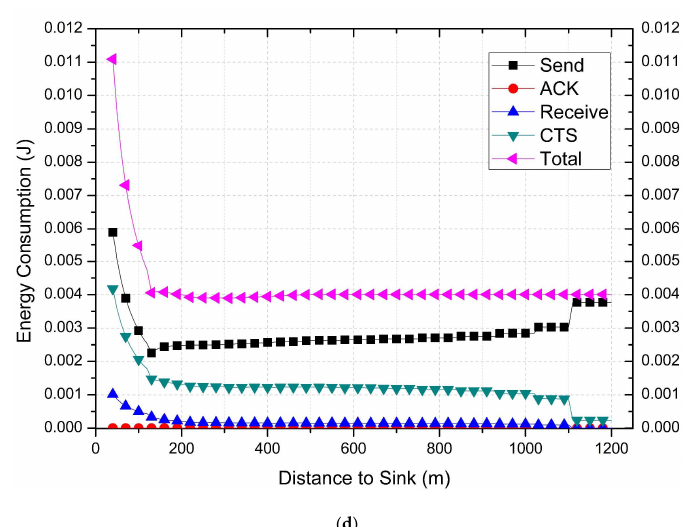
Figure 21. ( a ) Energy consumption of node under r =60, N = 2; ( b ) Energy consumption of node under r = 70, N = 3; ( c ) Energy consumption of node under r = 80, N = 4; ( d ) Energy consumption of node under r = 90, N = 4.